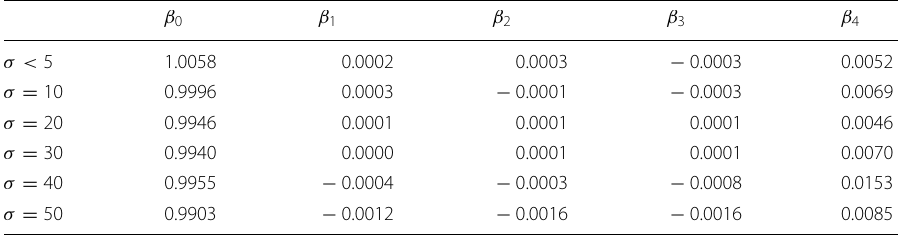
Table 2 The learned { β k } for real natural images with different levels of